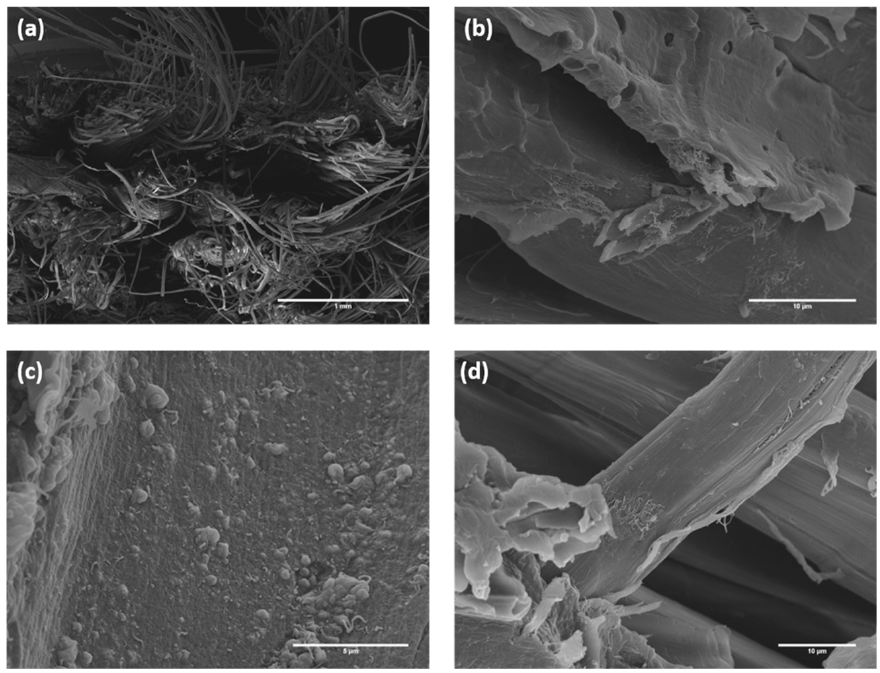
Figure7. SEMmicrographsofthefracturesurfacesofPP / Figure 7. SEM micrographs of the fracture surfaces of PP/Flax_CNT composites at different magnifications.